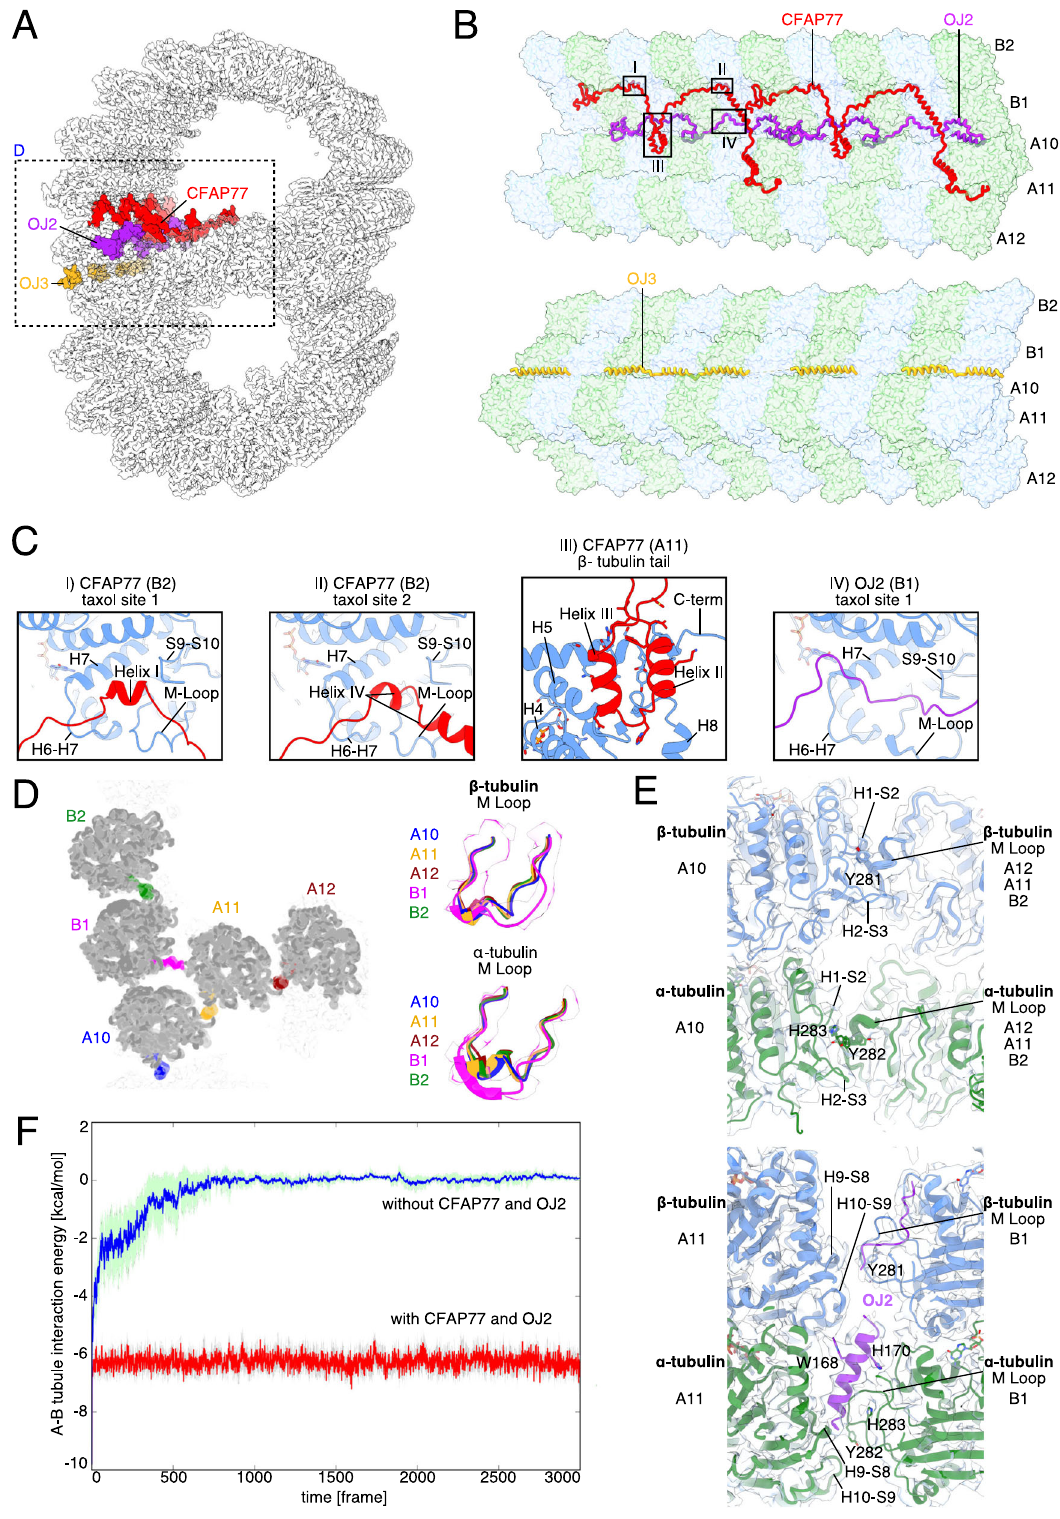
Fig. 5 | CFAP77 stabilizes the outer junction. A Cross-sectional view of the Tet- rahymena outer junction highlighting proteins CFAP77 (red), OJ2 (purple) and OJ3 (yellow). B Architecture of the Tetrahymena outer junction including proteins CFAP77, OJ2 and OJ3. C Helices of CFAP77 occupy taxane-binding pockets of β - tubulin of PF B2. A loop of OJ2 occupies the taxane-binding pocket of β -tubulin of PF B1. The helix-turn-helix motif of CFAP77 is positioned near the C-terminus of β - tubulin of PF A11. D Cross-sectional view of the OJ. M-loops of tubulins are colored